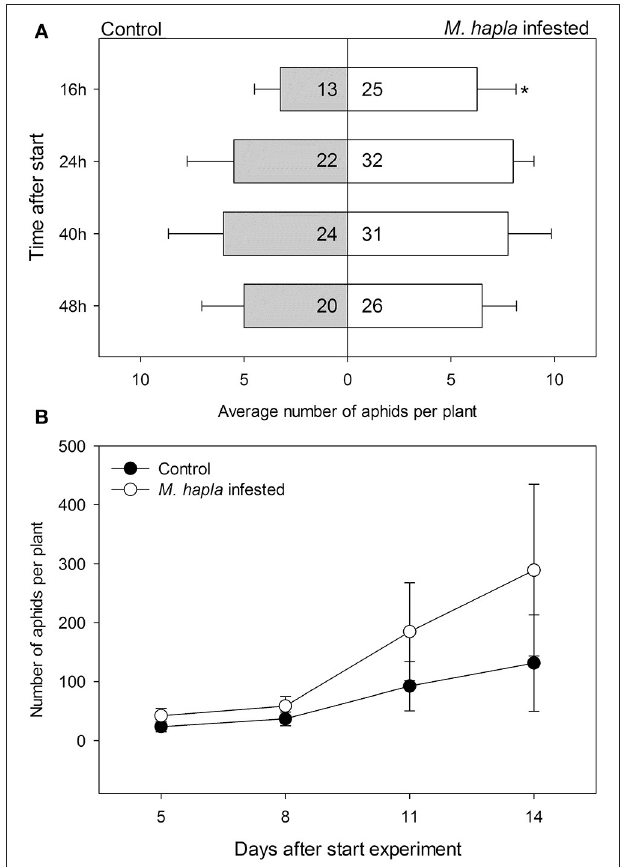
FIGURE 3 | Average numbers ( ± SEM) of Brevicoryne brassicae aphids found per plant. (A) Number of aphids at 16, 24, 40, and 48h after 20 winged aphids were released in each cage ( n = 4). The aphids were allowed to choose between a control plant (gray bars) and a plant infested with Meloidogyne hapla nematodes (white bars) enclosed in a single cage. In the bars: sum of aphids out of 80 released in total found on plants in the respective treatment group. The remaining aphids were not found on any plant at the times the aphids were counted. The asterisks indicate whether the distributions of the aphids overall were deviating from a 1:1 distribution (replicated G -test per time point, Gpooled, d.f. = 1); * p < 0.05. (B) Numbers of aphids on either plant from 5 to 14 days after aphids were released. Black circles: control plants, white circles: M. hapla infested plants. Both plants were left in the same insect cage over the course of the experiment; the resulting numbers thus are a combination of growth rates and redistribution of aphids.